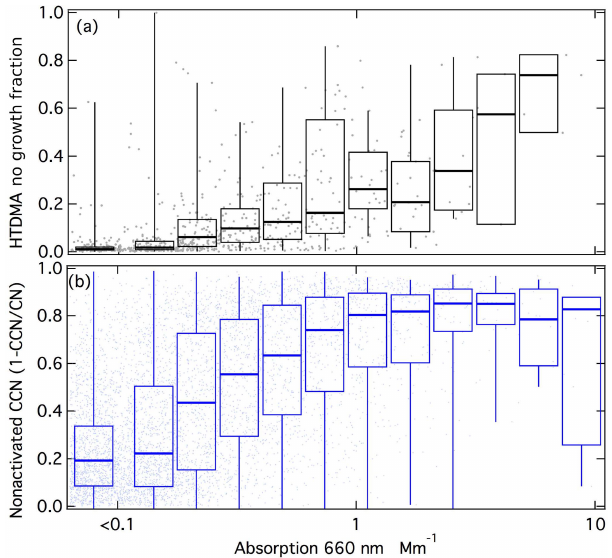
Figure 2. Scatter and box-whisker plot of PSAP 660nm absorption and (a) HTDMA no growth fraction ( r = 0.52); (b) nonactivated CCN fraction (1-CCN / SLCE-removed CN) for 1% supersatura- tion ( r = 0.34). The boxes show the 25th, 50th, and 75th percentile values; the whiskers show the minimum and maximum